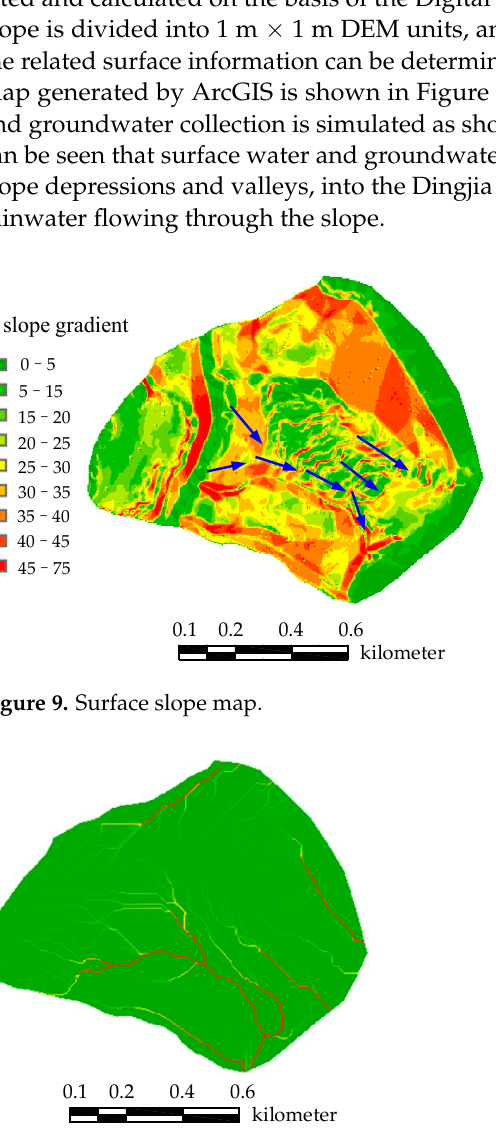
Figure 11. Slope unit flow diagram (unit: m 3 /d ). When simulating the groundwater flow, the permeability of the slope soil and stor- age time of the water flow are considered. Under the same rainfall conditions, the ground- water flow per unit of time on the same slope increases with the increase in thickness of the soil layer because the slope covering a thinner soil layer has limited space and capacity for rainwater seepage, so part of the rainwater seeps into the soil in a short period of time. Therefore, the amount of rainfall recharge on the slope depends on the thickness of the soil layer of the corresponding slope unit, rainfall intensity, rainfall duration, the initial water content of the soil, the surface cover, the surface slope, etc., and the groundwater flow is positively correlated with the thickness of the soil layer. When the rainfall contin- ues, the groundwater level will rise continually, which causes the slope to appear full and saturated. At this time, the groundwater flow will be discharged from the slope through